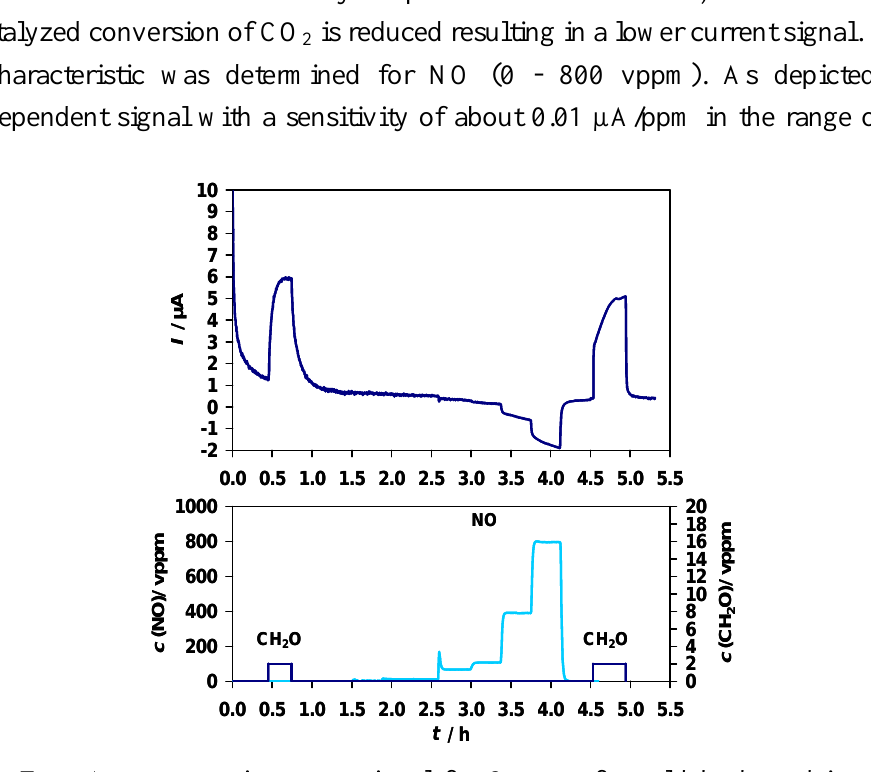
Figure 9. Top: Amperometric sensor signal for 2 vppm formaldehyde and interferences from NO (0 - 800 vppm) in the gas phase. Bottom: Test cycle concentrations of NO (left y-axis) and formaldehyde (right y-axis).